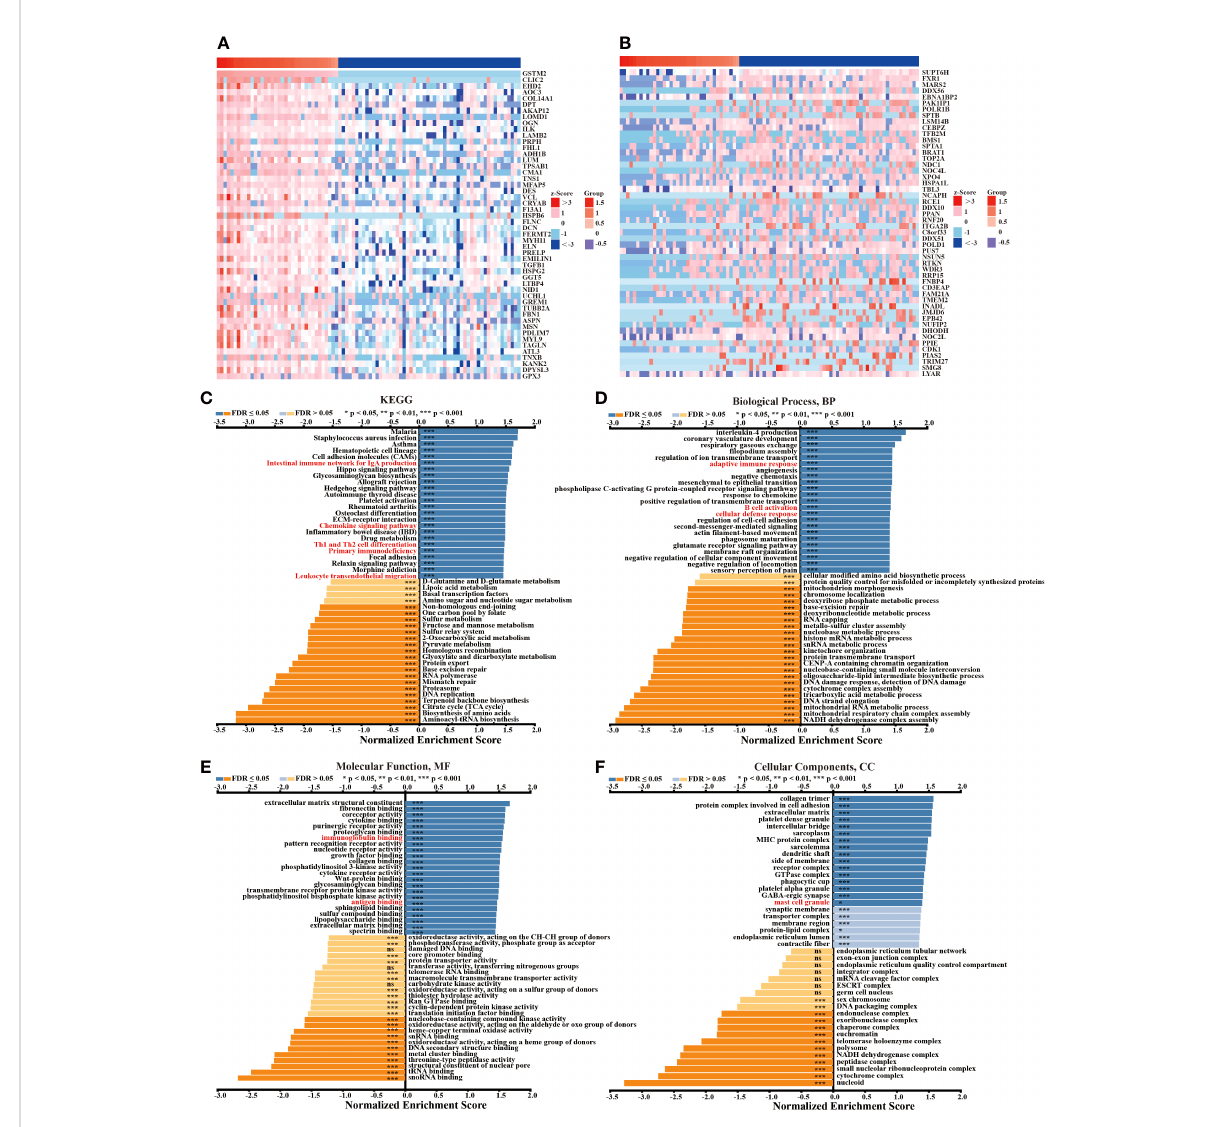
FIGURE 5 The Functions of GSTM2 in Colon Cancer might be Associated with Immune Modulations. (A) Heat maps of the top 50 genes positively correlated with GSTM2 expression. (B) Heat maps of the top 50 genes negatively correlated with GSTM2 expression. (C – F) GSEA analysis showing the positively and negatively correlated pathways of GSTM2. ns: not statistically signi fi cant, *p < 0.05, and ***p <